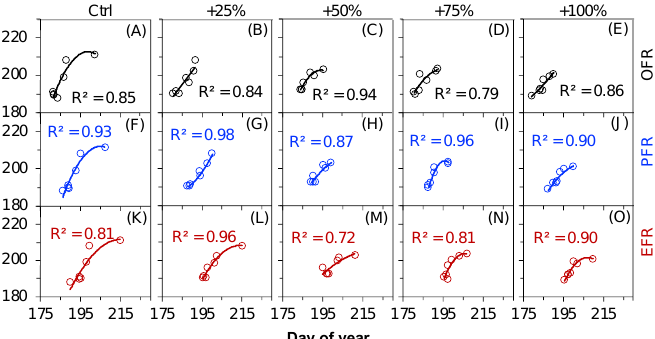
Figure 7. Correlations between the onset ( A – E ), peak ( F – J ), and end ( K – O ) of the fruit ripening events and the onset of seed release (OSR) of Nitraria tangutorum . The solid lines indicate p ≤ 0.05. OFR, PFR, and EFR represent the onset, peak, and end of the fruit ripening period, respectively.